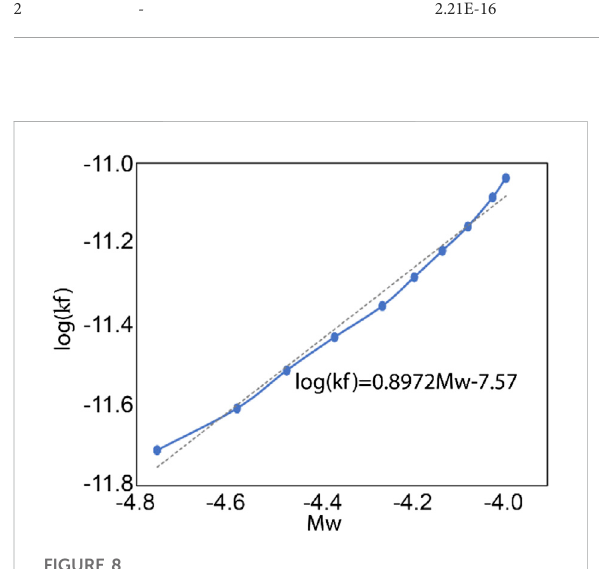
FIGURE 8 Log – log plot of the fracture permeability versus the seismic moment magnitude. Data from Li et al. (2021).